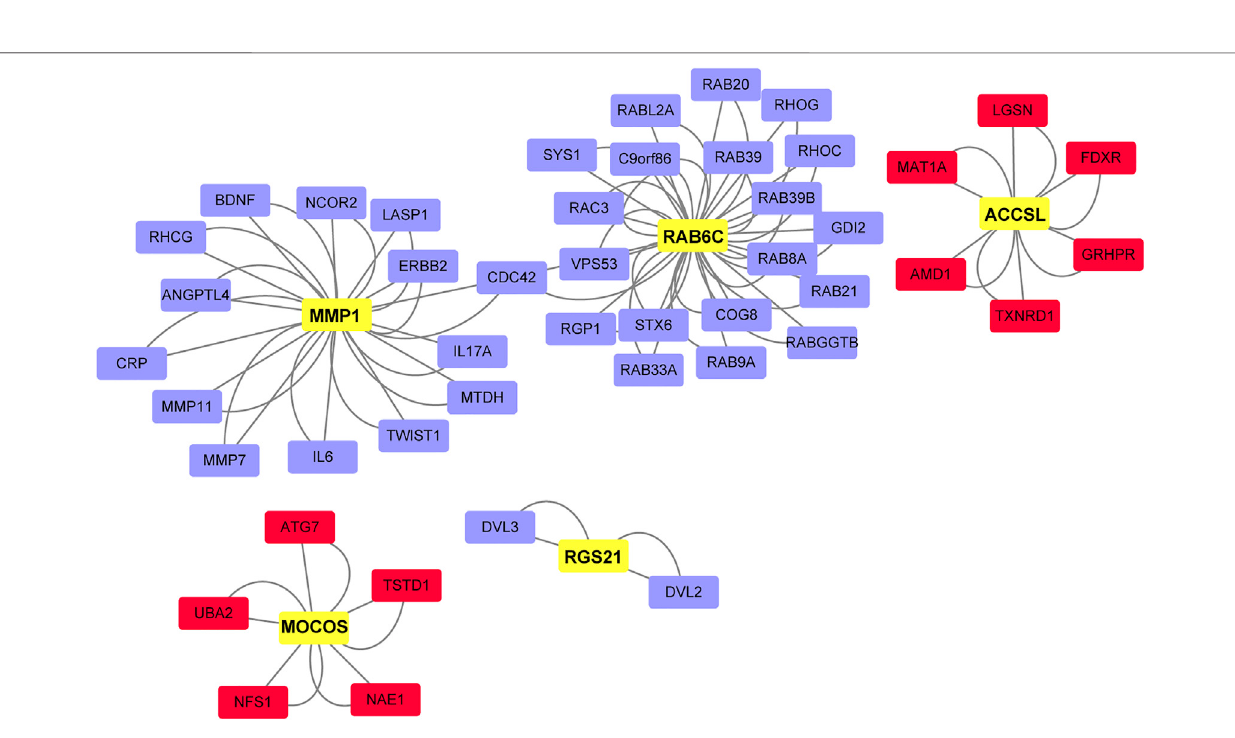
Frontiers in Genetics |